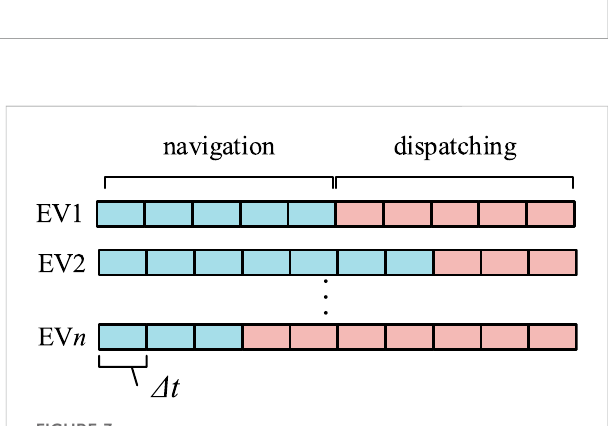
FIGURE 3 Coupling of navigation and dispatching on the time